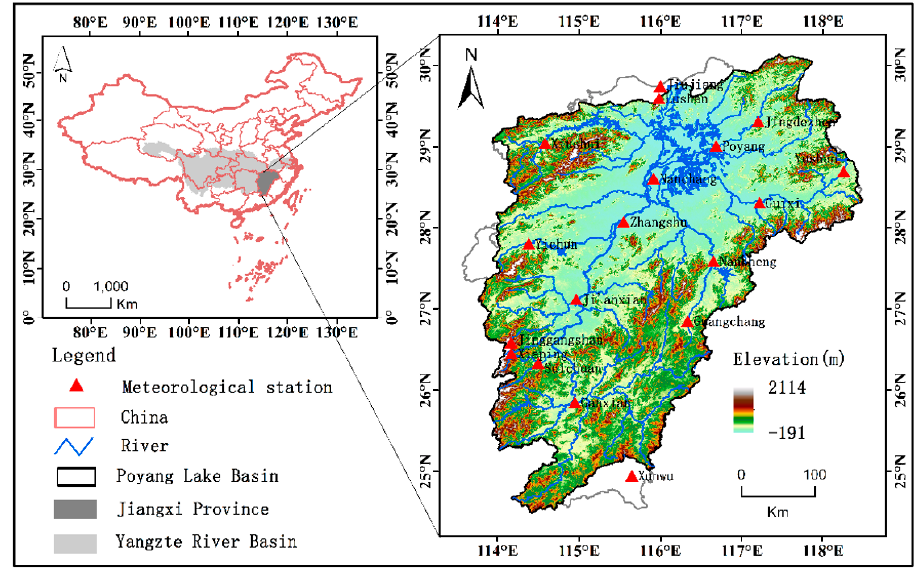
Figure 1. Location of the Poyang Lake Basin and distribution of eighteen meteorological stations.